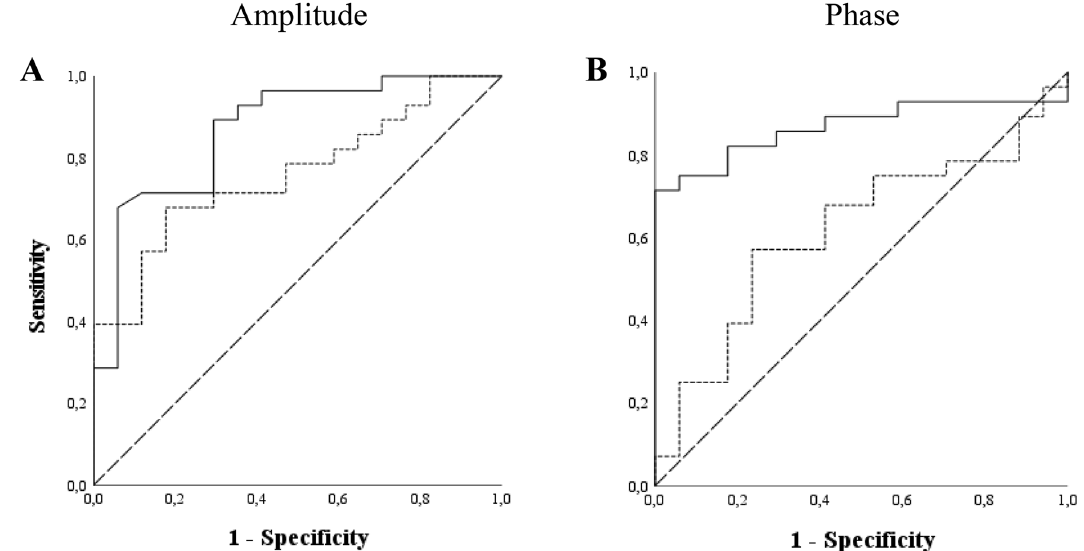
Figure 4. Receiver Operating Characteristic (ROC) curve and Area Under the Curve (AUC) calculated for ( A ) PERGx amplitude slope (solid line; AUC = 0.87) and grand-average vector amplitude (densely dashed line; AUC = 0.76) and for ( B ) PERGx grand-average vector phase (solid line; AUC = 0.87) and phase angular dispersion (densely dashed line; AUC = 0.62). The dashed diagonal line serves as an imaginary reference line representing a non-discriminatory